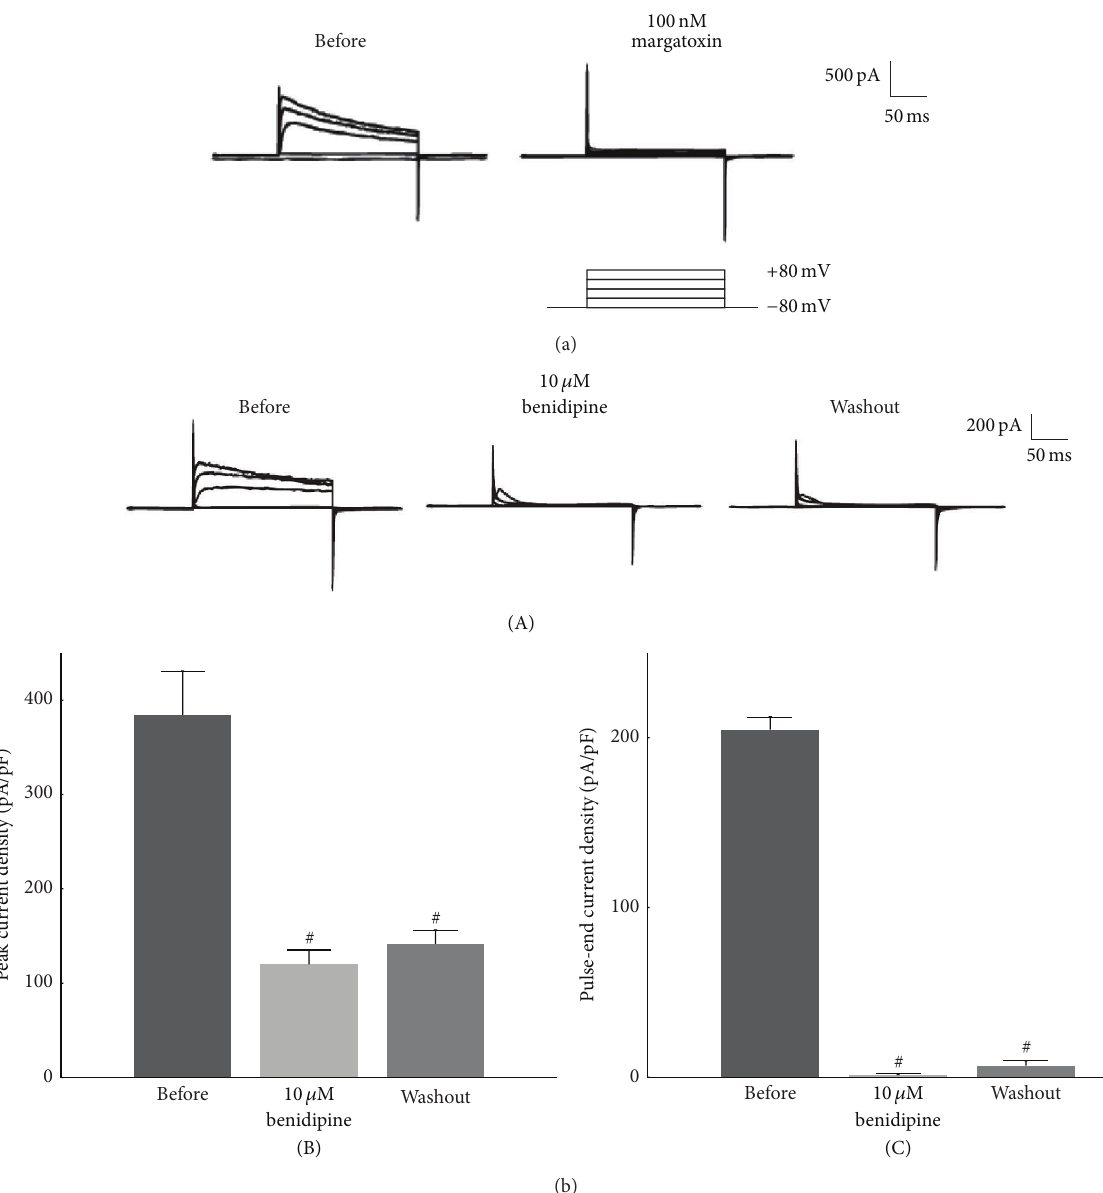
Figure 3: Effects of margatoxin and benidipine on Kv1.3 channel currents in murine thymocytes. Typical whole-cell current traces at different voltage steps recorded before and after the application of 100nM margatoxin (a) or 10 𝜇 M benidipine ((b)(A)). The currents were elicited by voltage-steps from the holding potential of − 80 mV to − 40, 0, 40, and 80mV, as depicted in the voltage protocol. Each pulse was applied for a 200-ms duration between 10-second intervals. (b)(B) Peak current densities (peak currents normalized by the membrane capacitance) obtained from the records in (A) at the voltage-step of 80 mV. (b)(C) Pulse-end current densities (pulse-end currents normalized by the membrane capacitance) obtained from the records in (a) at the voltage-step of 80 mV. # 𝑃 < 0.05 versus before the drug application. Values are means ± SEM ( 𝑛 = 5 ). Differences were analyzed by ANOVA followed by Dunnett’s or Student’s 𝑡 -test. Modified from [18,